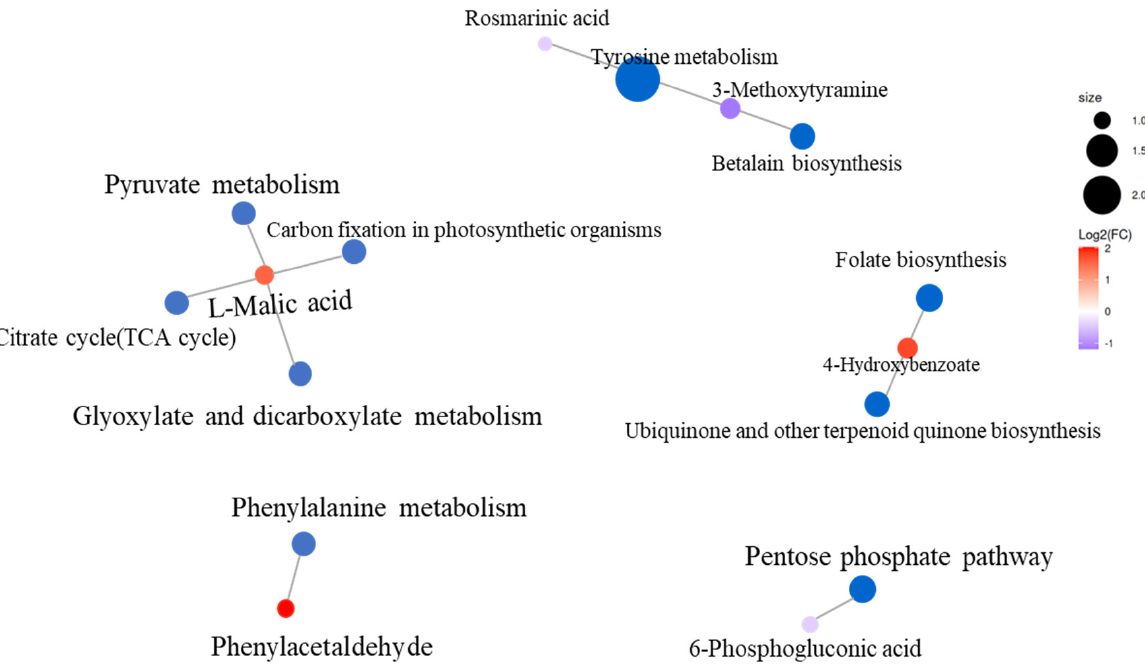
Figure 7. The network diagram shows the KEGG pathway where differential metabolites are mainly enriched.